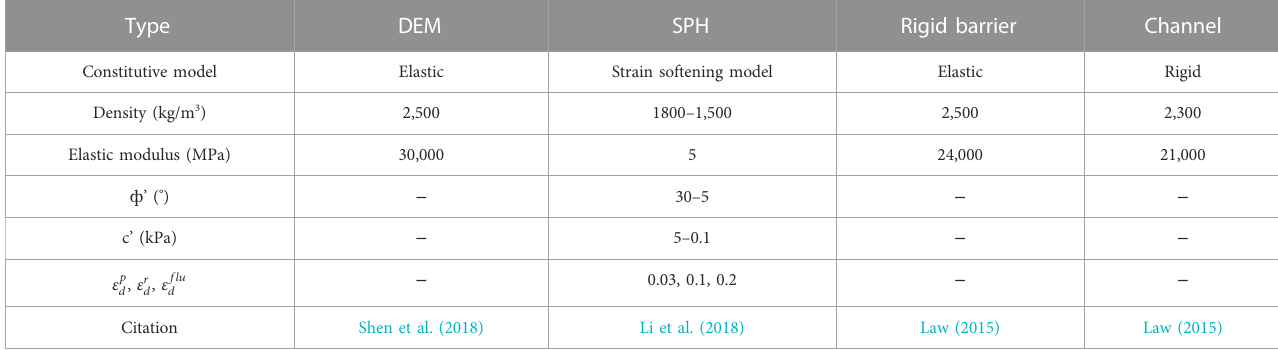
TABLE 3 Basic parameters of numerical